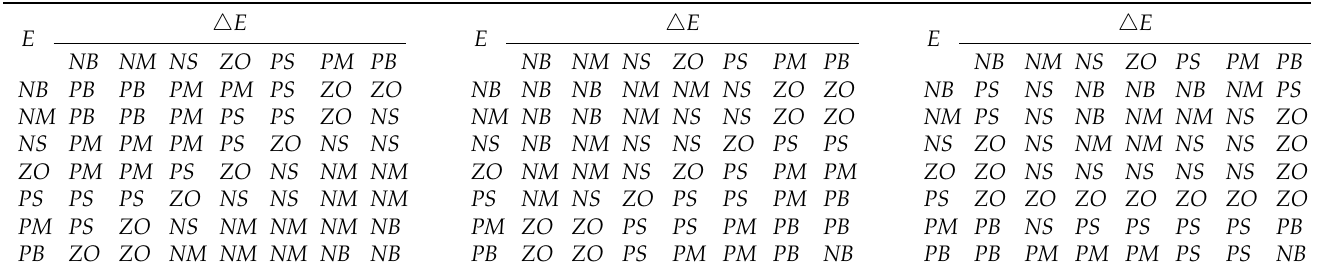
Table 2. Fuzzy Inference Rules of k p , k i , k d